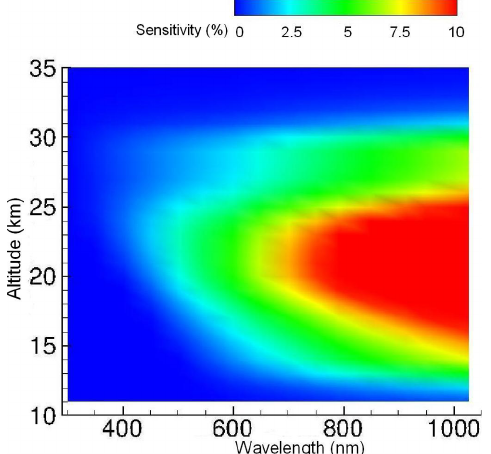
Fig. 1. Sensitivity of SCIAMACHY limb radiance to stratospheric aerosol. Sensitivity is defined as the maximum change [%] of limb radiance due to 1% change in aerosol extinction.